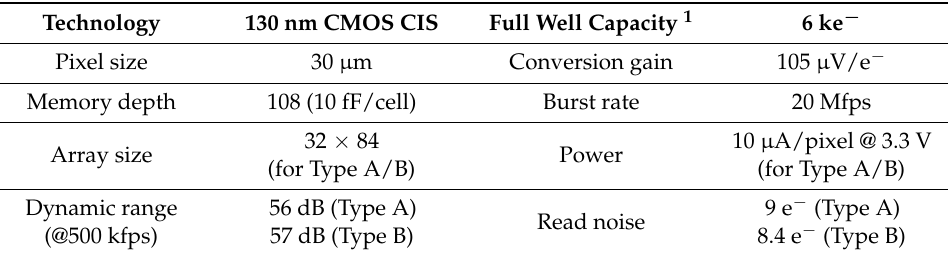
Table 1. Test imager specification